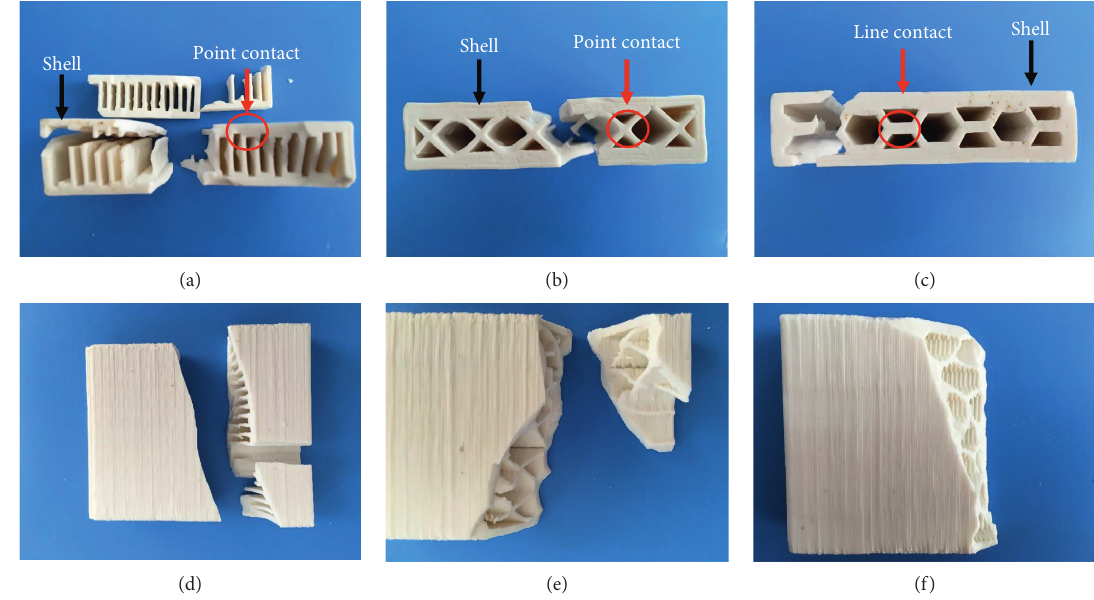
Figure 7: Failure modes in perpendicular direction and fracture surfaces of samples: (a) vertical supporting structure, (b) oblique square grid supporting structure, (c) honeycomb grid supporting structure in parallel direction, (d) vertical supporting structure, (e) oblique square grid supporting structure, and (f) honeycomb grid supporting structure.